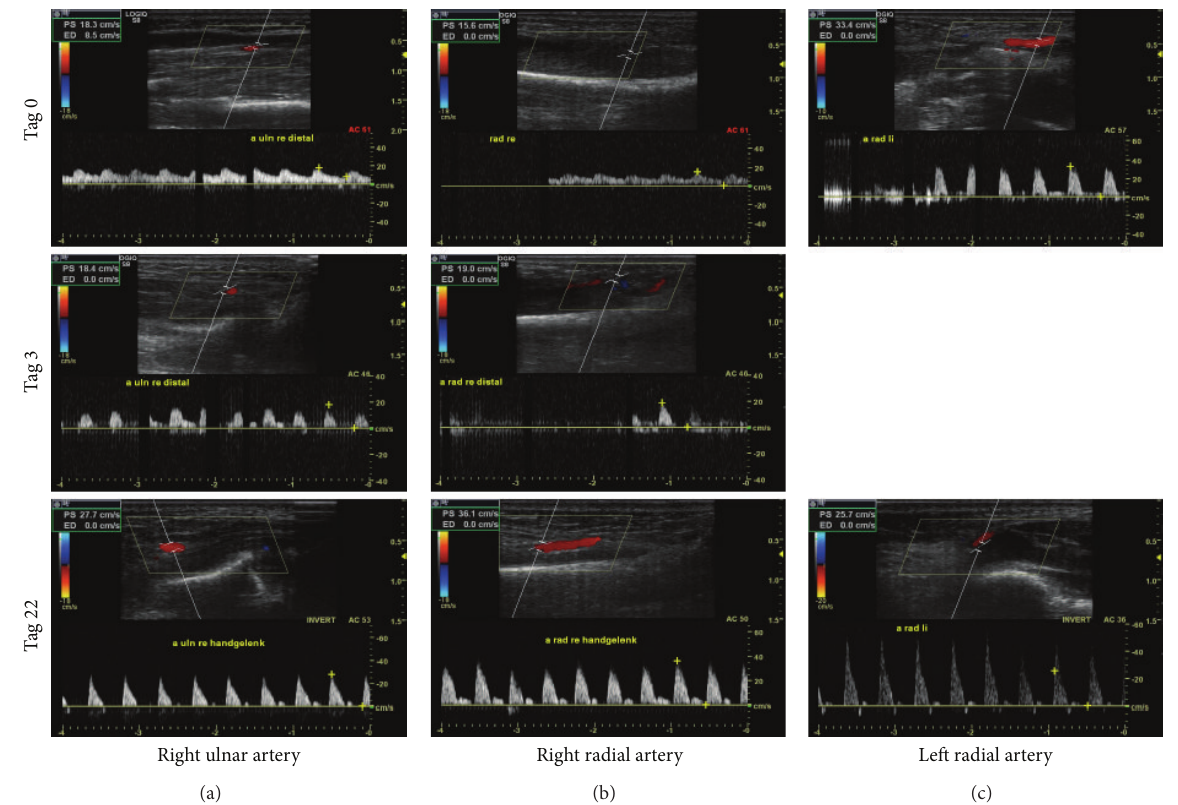
Figure 2: Velocities of the right radial and ulnar arteries (on day 0 and day 3 and after recanalization on day 22), compared to the left radial artery on days 0 and